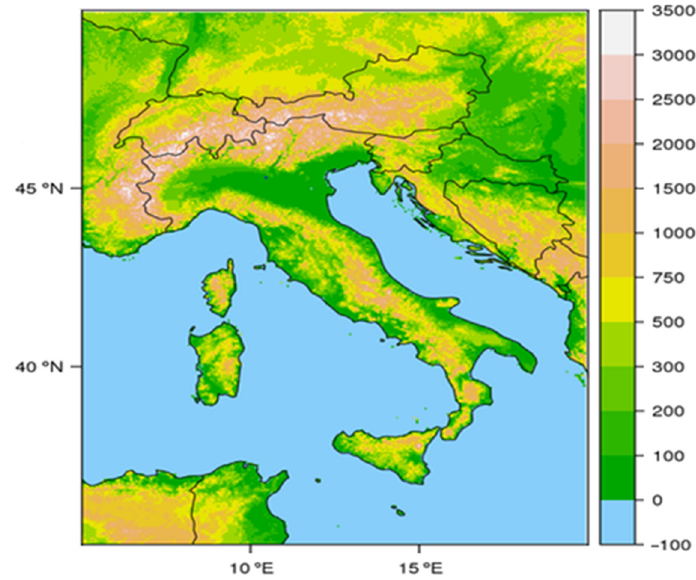
Figure 1. Analysis domain with orography description. A set of 14 high-resolution Euro-CORDEX models (daily meteorological data at a horizontal resolution of 0.11°, about 12 km, ref [31] was considered (Table 1) to elaborate climate change scenarios from 1971 to 2100.